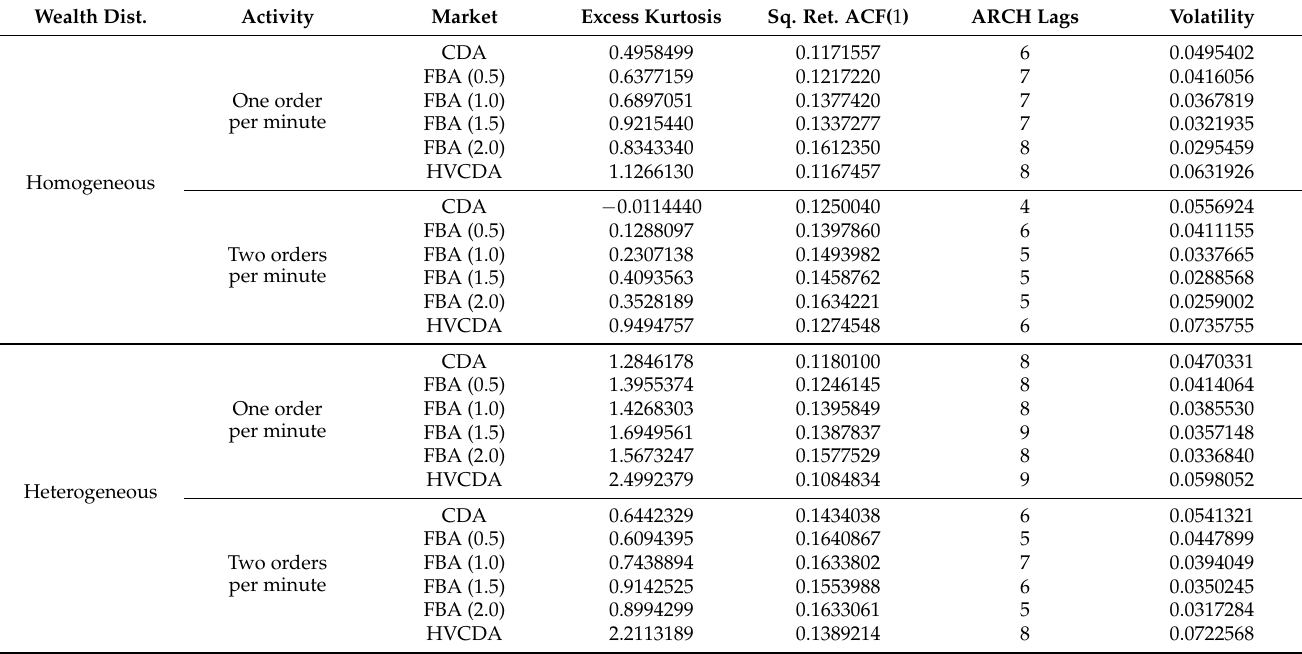
Table 3. Summarized statistics of 2-s